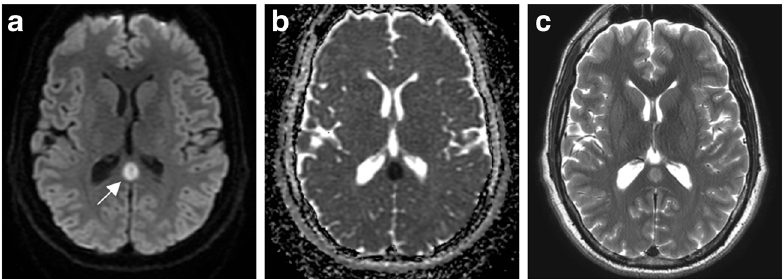
Fig. 9 Transient lesion of the splenium. Twenty-seven-year-old man with epilepsy on anti-seizure medications, presenting with complex partial seizure. DWI ( a ) demonstrates a rounded focus of increased signal